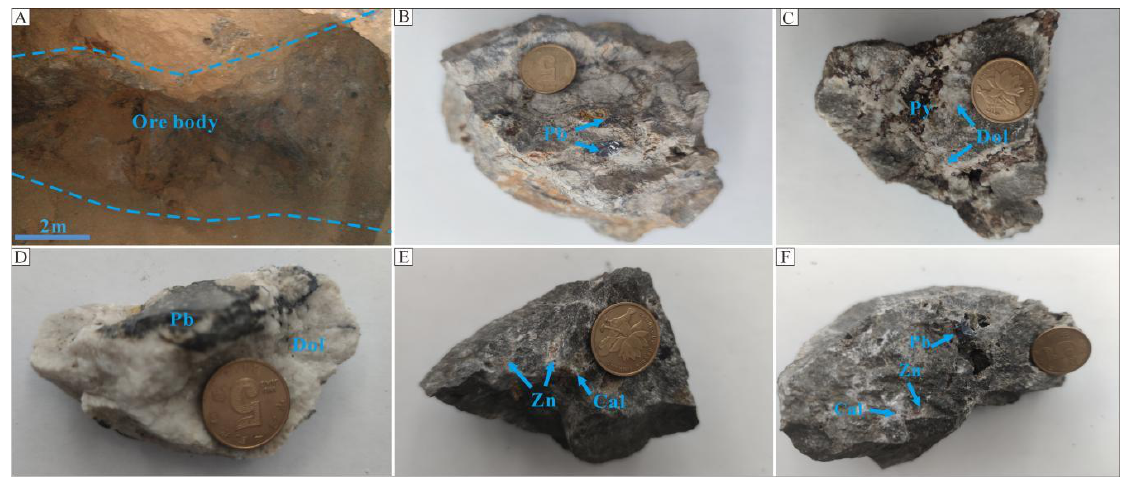
Figure 4. The Pb-Zn orebody and ore structure of Lekai Pb-Zn deposit. ( A ) Stratoid Pb-Zn orebodies occur within interlayer fracture zone; ( B ) Brecciated Pb-Zn ore, Galena occurs in brecciated dolomite as an agglomerate; ( C ) Disseminated Pb-Zn ore, Veined dolomite and pyrite occur in altered dolomite; ( D ) Cloddy Pb-Zn ore, Agglomerate and veined galena occur in dolomite; ( E ) Disseminated Pb-Zn ore, Agglomerate sphalerite and calcite occur in dolomite; ( F ) Cloddy Pb-Zn ore, Sphalerite, galena, and calcite are filled within the dolomite pores. Sp = sphalerite; Py = pyrite; Gn = galena; Cal = calcite; Dol = dolomite.